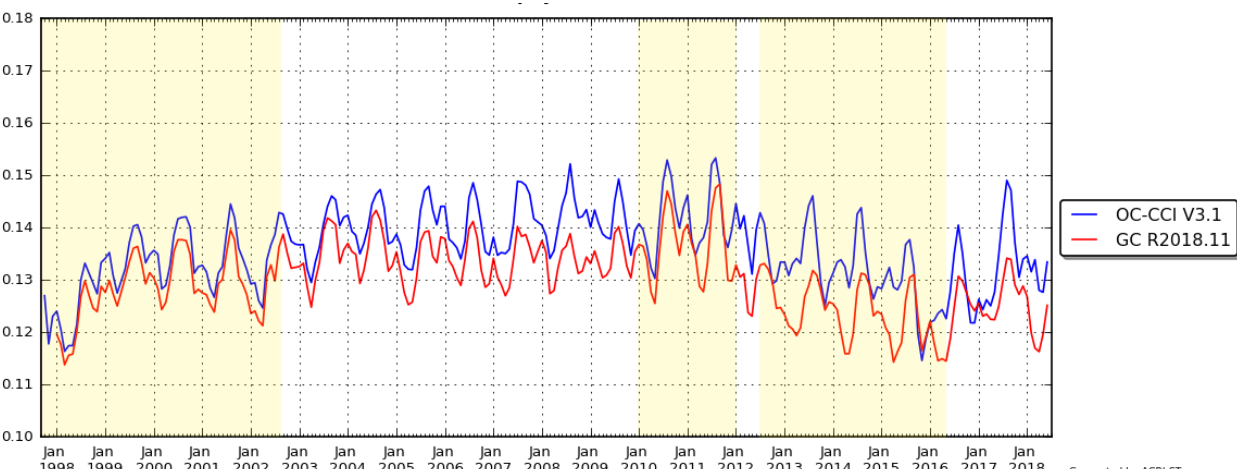
Figure 7. Comparison of the global median chlorophyll a concentration as function of time for OC-CCI v3.1 (blue line) and GlobColour R2018.11 (red line) at the global level and for common pixels. The yellow shaded sections show the change of sensor combinations. The discontinuities and trends of the median with time should be interpreted carefully according the sensors